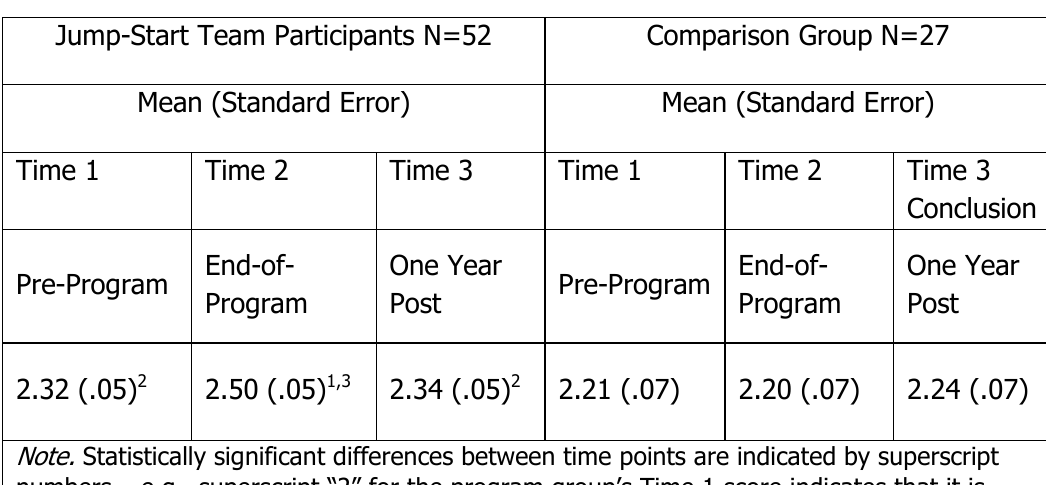
Changes Over Time in Community Organizing